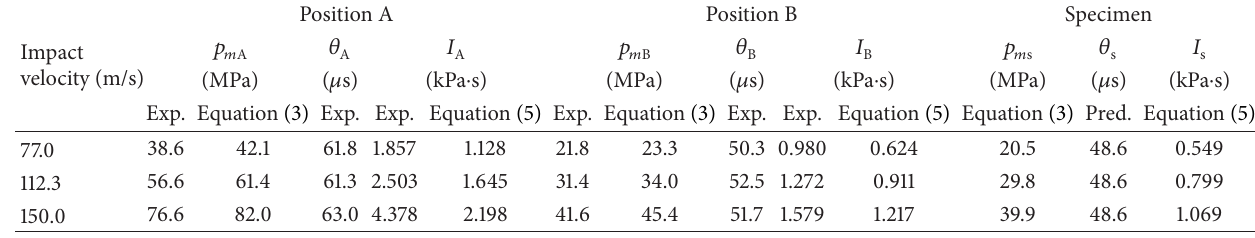
Table 2: Characteristic parameters of underwater impulsive loads.